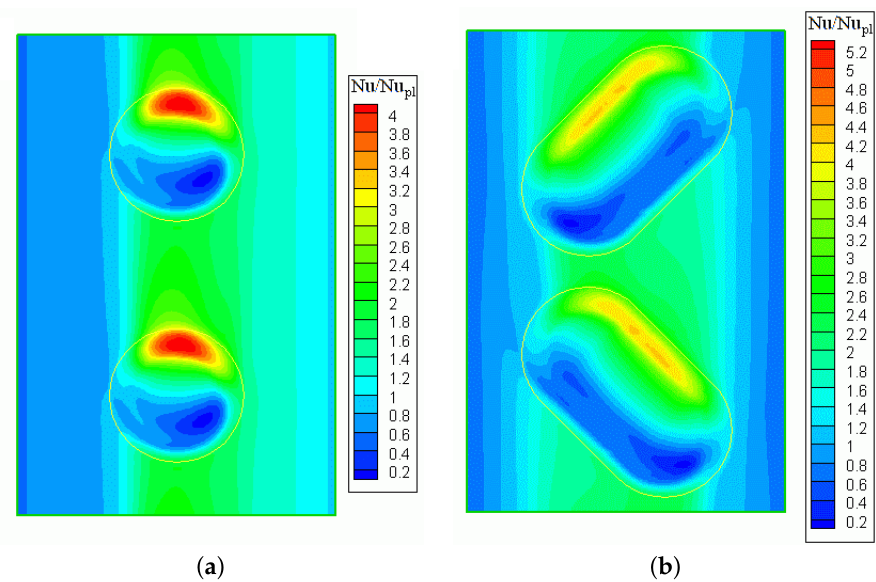
Figure 6. Comparison of relative Nusselt number fields on the wall with spherical ( a ) and oval ( b ) dimples in the periodic module.